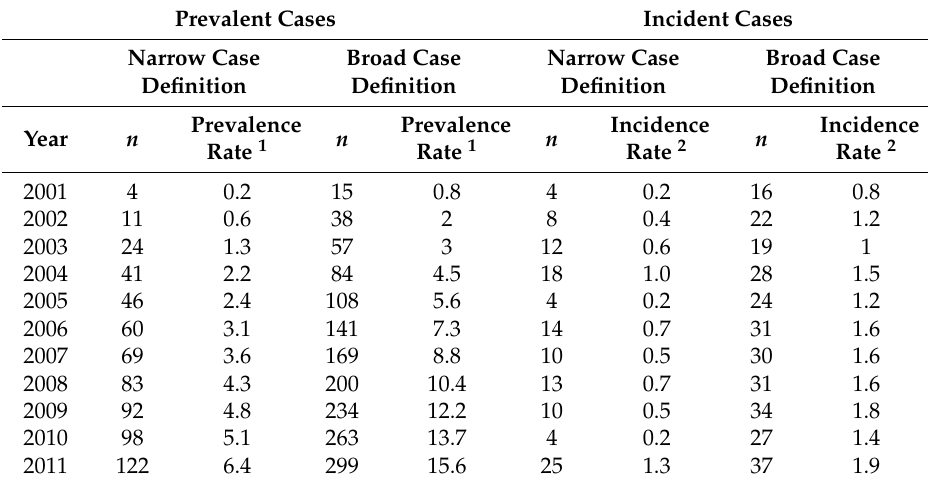
Table 1. Prevalent and incident cases of IPF from 2001 to 2011 by case definition. Prevalent Cases Incident Cases Narrow Case Broad Case Narrow Case Broad Case Definition Definition Definition